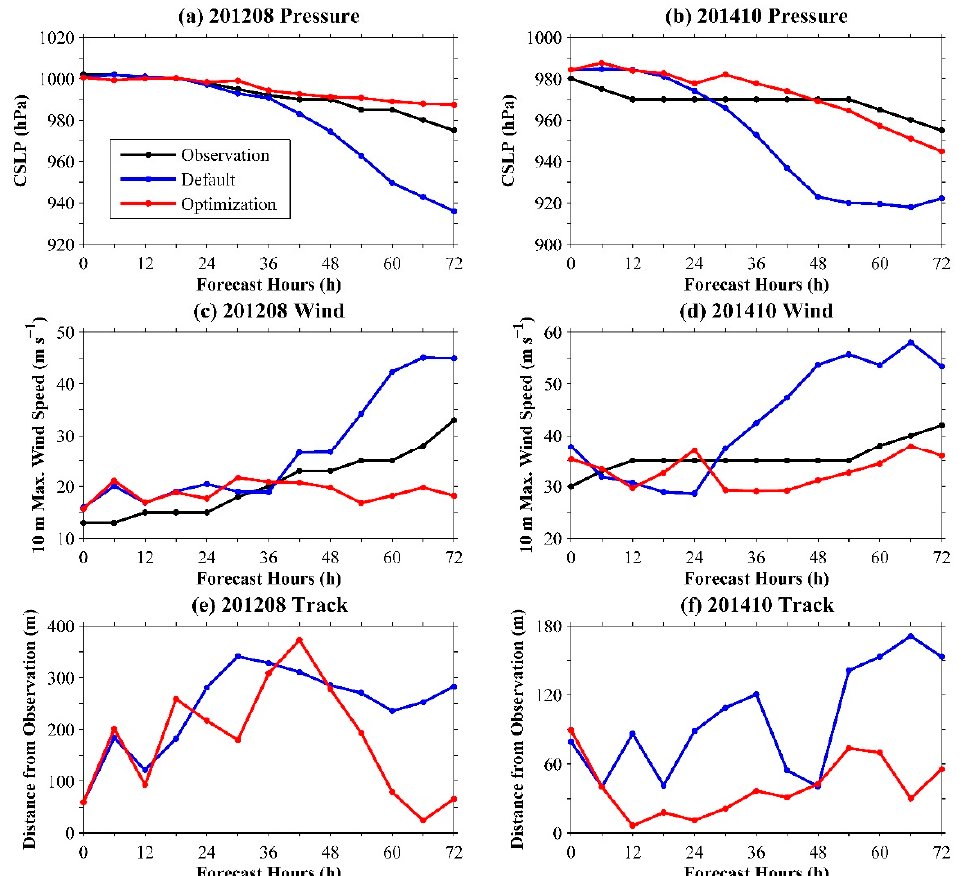
Figure 9. The comparisons of the intensity and track simulations for typhoon Vicente (201208) and typhoon Matmo (201410) using the default and optimal scheme combinations. ( a , b ), ( c , d ), and ( e , f ) represent the comparisons of the CSLP, 10-m wind, and track simulations, respectively. The observations are also from the CMA-STI best track dataset for tropical cyclones over the Northwest Pacific Ocean.